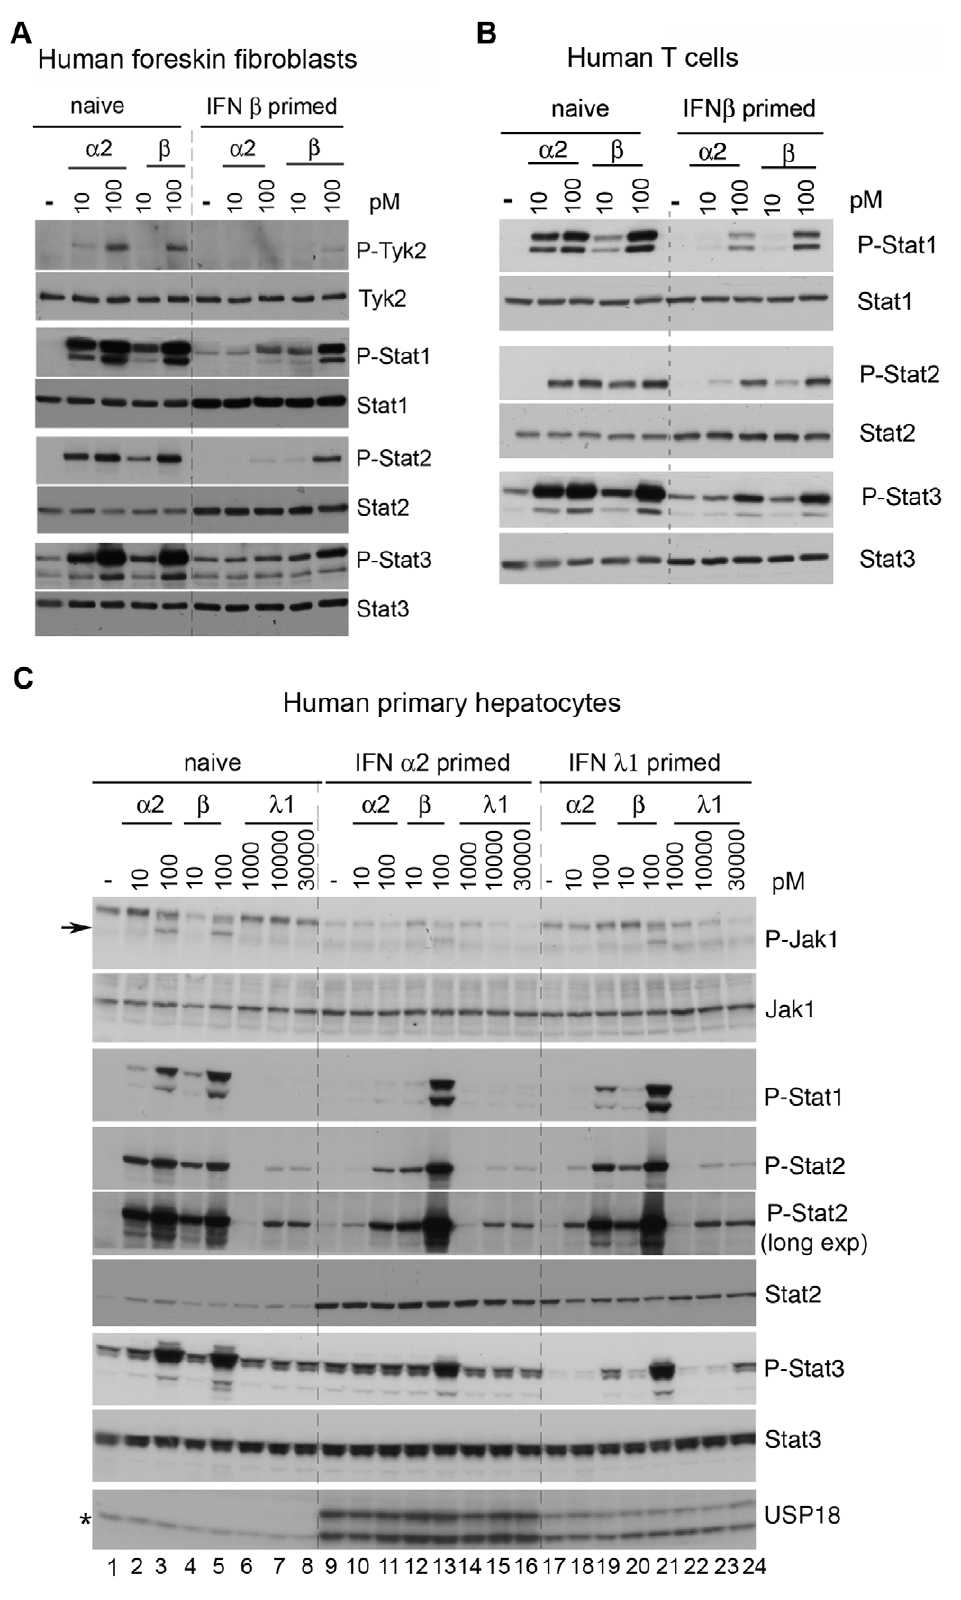
Figure 3. Differential desensitization of human primary cells. (A) Human foreskin fibroblasts and (B) human T cells were either left untreated (naı¨ve) or primed for 8 hr. Cells were washed, maintained in medium without IFN for 16 hr and stimulated for 30 min with 10 and 100 pM of the indicated IFN. Cell lysates (30 m g) were analysed with the indicated Abs. (C) Human primary hepatocytes were left untreated (naı¨ve) or primed with 500 pM of IFN a 2 or 30 nM of IFN l 1 for 24 hr. Cells were washed, maintained in medium without IFN for 24 hr and stimulated for 30 min with the